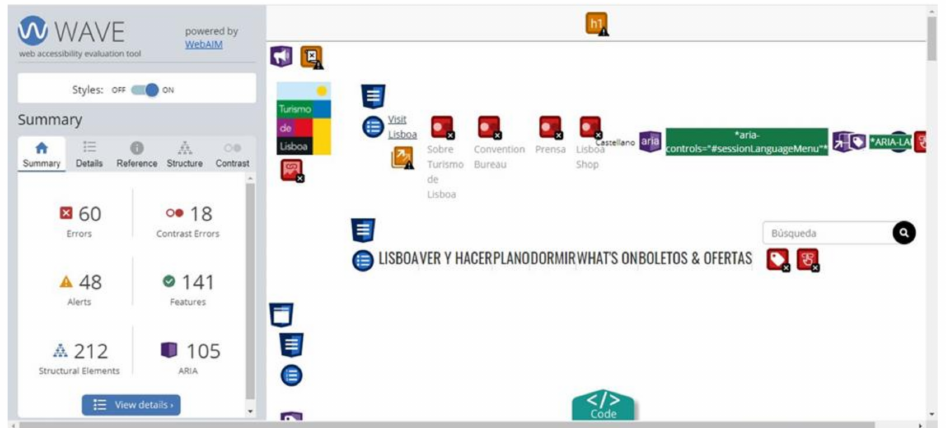
Figure 3. Example of the accessibility analysis of the official Lisboa Tourism website (www.visitlisboa. com) using the Wave tool. Source: own elaboration from Wave [54]. Red “Errors” icons: These are errors that must be solved since they do not comply with WCAG 2.1.; recommendations on possible solutions are provided. ground and the text; the tool even indicates possible color